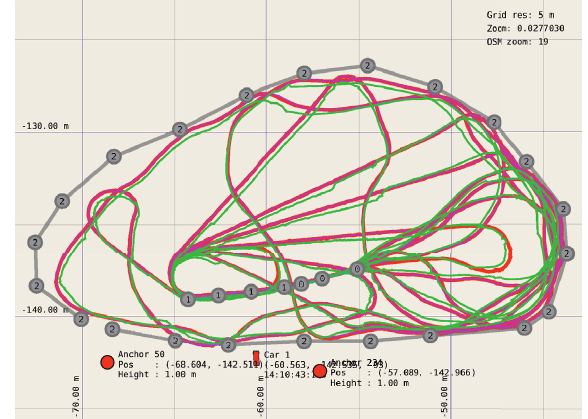
Figure 13: Traces after 10 test campaigns without FI. The RTK-SN traces are shown in magenta and the UWB traces are shown in green.